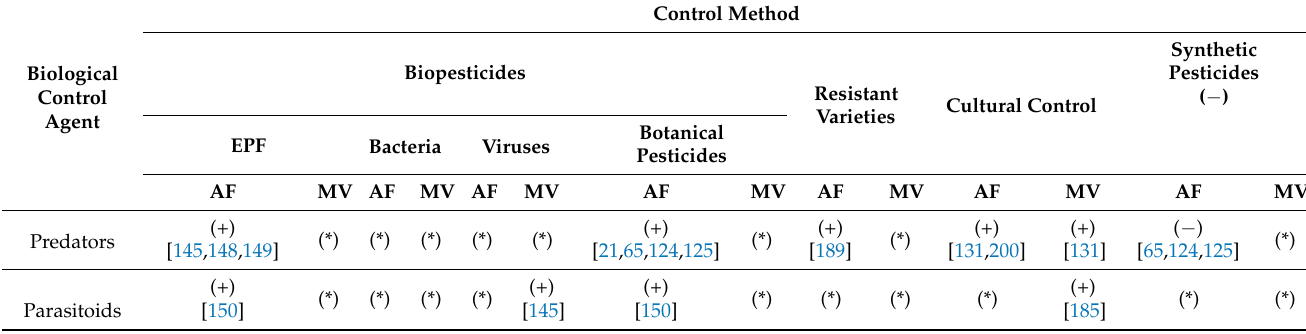
Biological Control